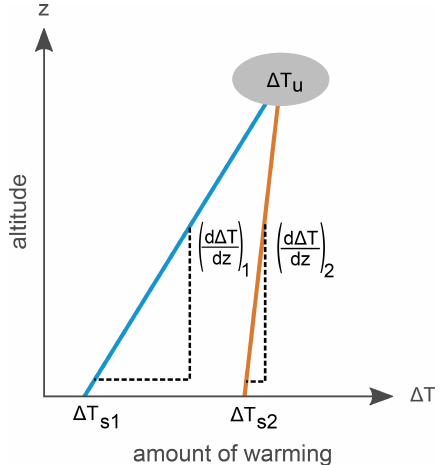
Figure 1. Geometrical illustration of how lapse-rate changes are re- lated to surface warming. The blue line ( d (cid:49)T/ d z) 1 shows a large lapse-rate change, as expected over the ocean, and the orange line ( d (cid:49)T/ d z) 2 a small lapse-rate change (( d (cid:49)T/ d z) 1 > ( d (cid:49)T/ d z) 2 ) , as expected over land. We assume that the warming in the upper troposphere ( (cid:49)T u ) is similar in both cases. From this assumption, it geometrically follows that the amount of surface warming is large ( (cid:49)T s2 ) where the lapse-rate change is small, and the surface warm- ing is small ( (cid:49)T s1 ) where the lapse-rate change is